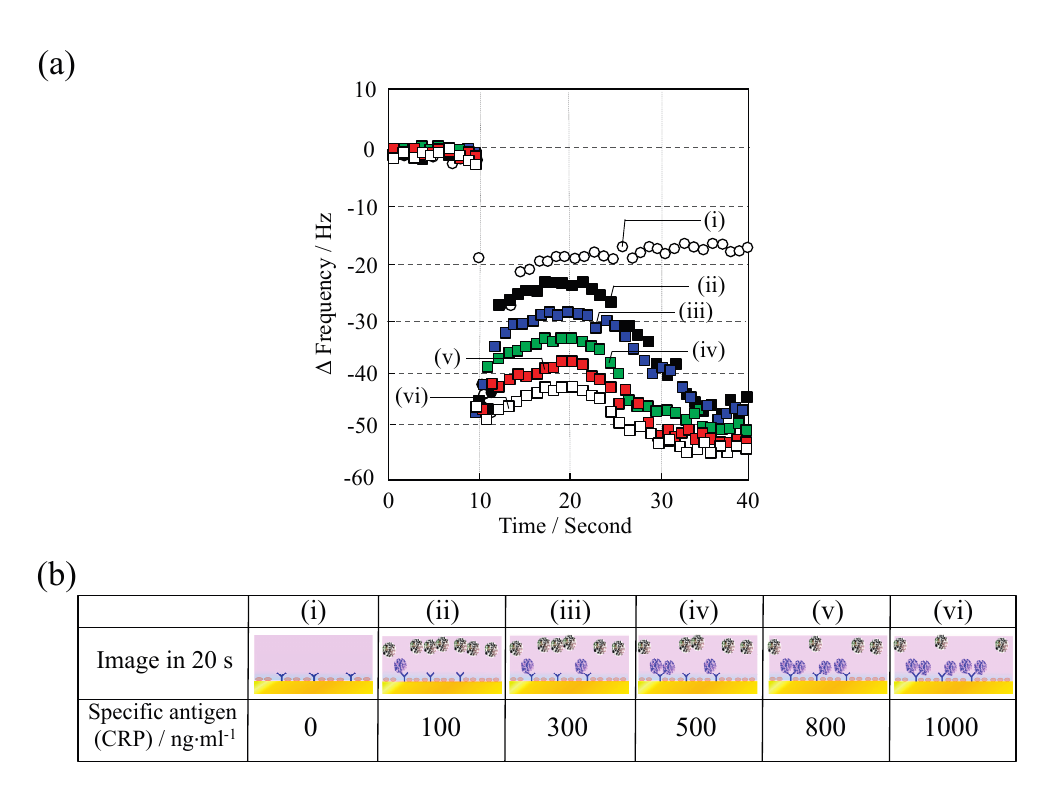
Figure 6. The frequency change as Δ f vs . time at various CRP concentrations (0–1000 ng·mL − 1 ): ( a ) QCM output obtained at different concentrations of CRP; ( b ) Adiponectin is released from the QCM sensor surface as the concentration of CRP increases.